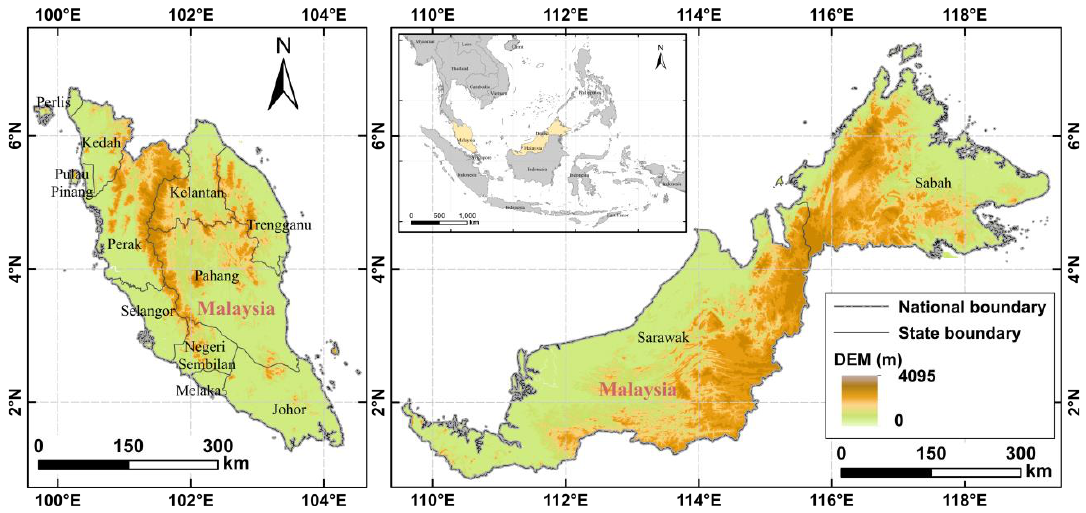
Figure 1. Map of the study area, showing its geographical location, topography, and elevation. DEM, digital elevation model.